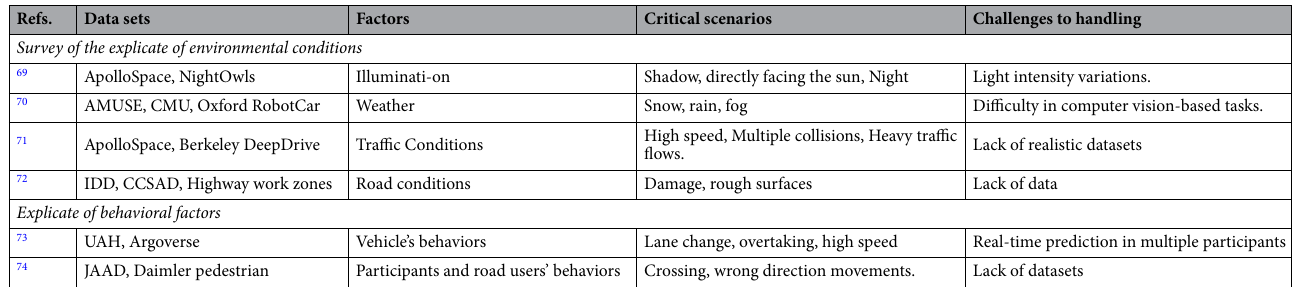
Table 3. Prominent survey papers represented data-sets with detailed